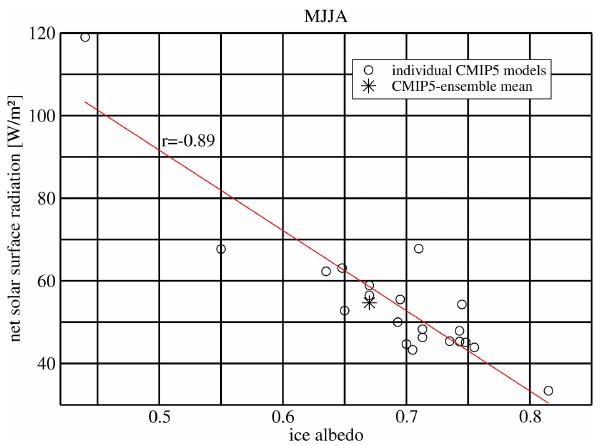
Fig. 10. Relation between summer (MJJA) mean sea ice albedo and net solar surface radiation flux of the ice-covered area averaged over 80–90 ◦